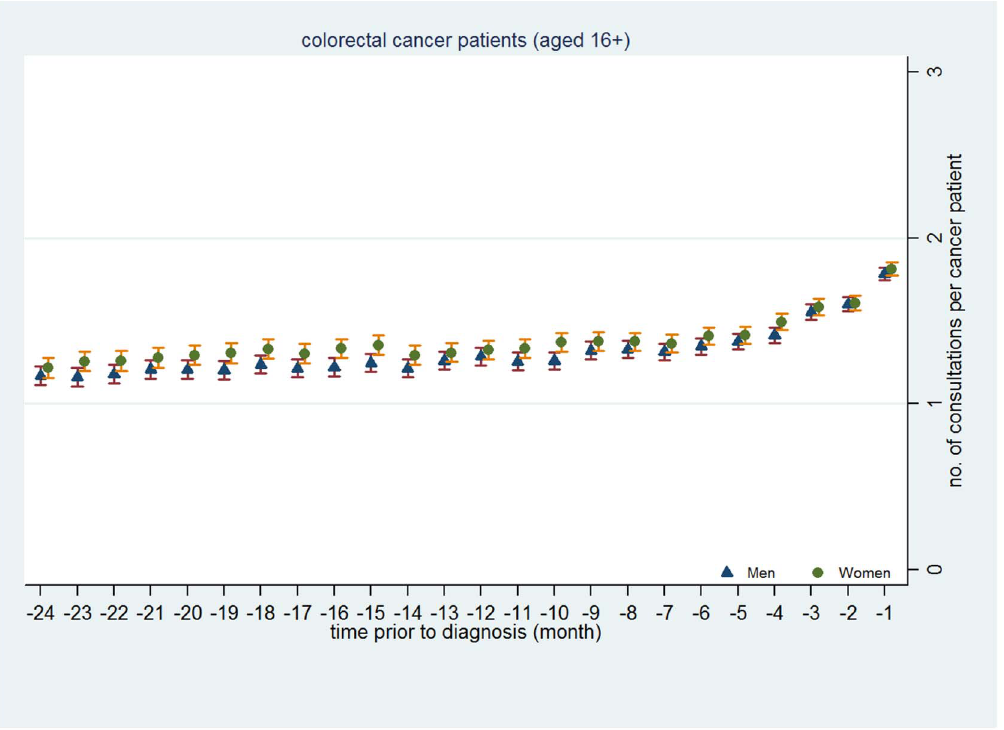
Figure 4. Mean number of primary care consultations per colorectal cancer patient made prior to cancer diagnosis by month and gender.